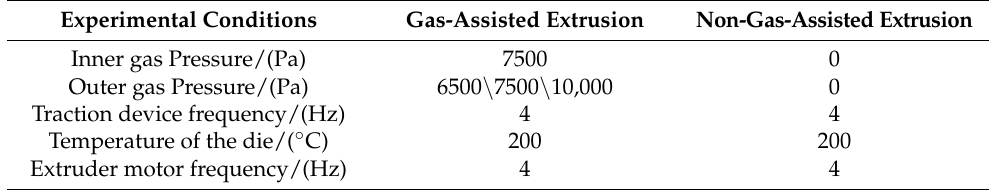
Table 2. Experimental